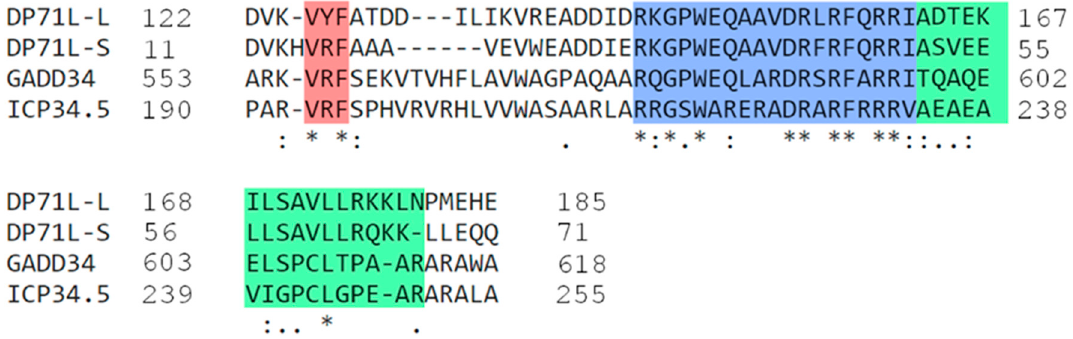
Figure 4. Alignment of ASFV DP71L with GADD34 and ICP34.5 of HSV-1. The long and short forms of DP71L share significant homology with the C-terminal domain of ICP34.5 of HSV-1 and GADD34. Within the C-terminal region of ICP34.5, residues 233–248 (shaded green) have been identified as the eIF2 α binding domain [55]. The LSAVL motif within this was identified as critical for function [48]. The eIF2 α binding motif described [56] in GADD34 is highlighted in blue. Identical amino acid residues shard between the sequences are shown with an asterisk (*) and similarities are shown as double (:) or single (.) dots.